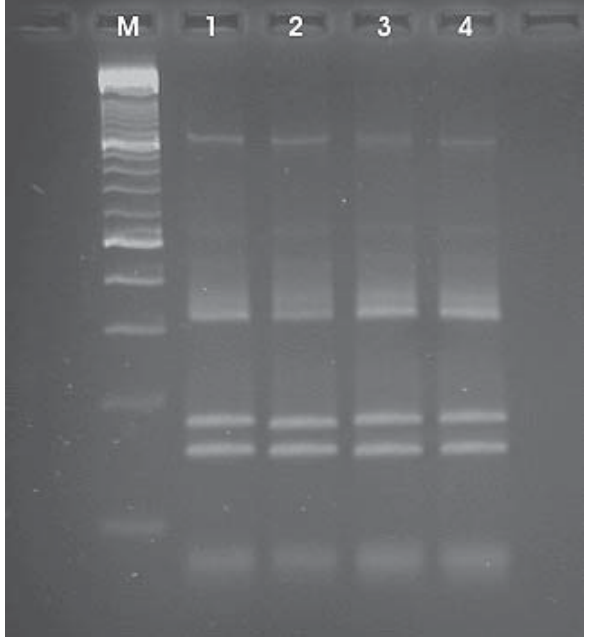
Fig. 3. Restriction analysis of the IGS region of the rDNA amplified by PCR, digested with Alu I and electro- phoresed in 3% agarose gel stained with ethidium bro- mide. Lanes 1–4, Armillaria mellea pattern mel 2 ob- tained from Vitis sp., Actinidia deliciosa , Castanea sati- va and Pinus pinaster . The outside lane (M) contains a 100 pb DNA molecular marker as a size